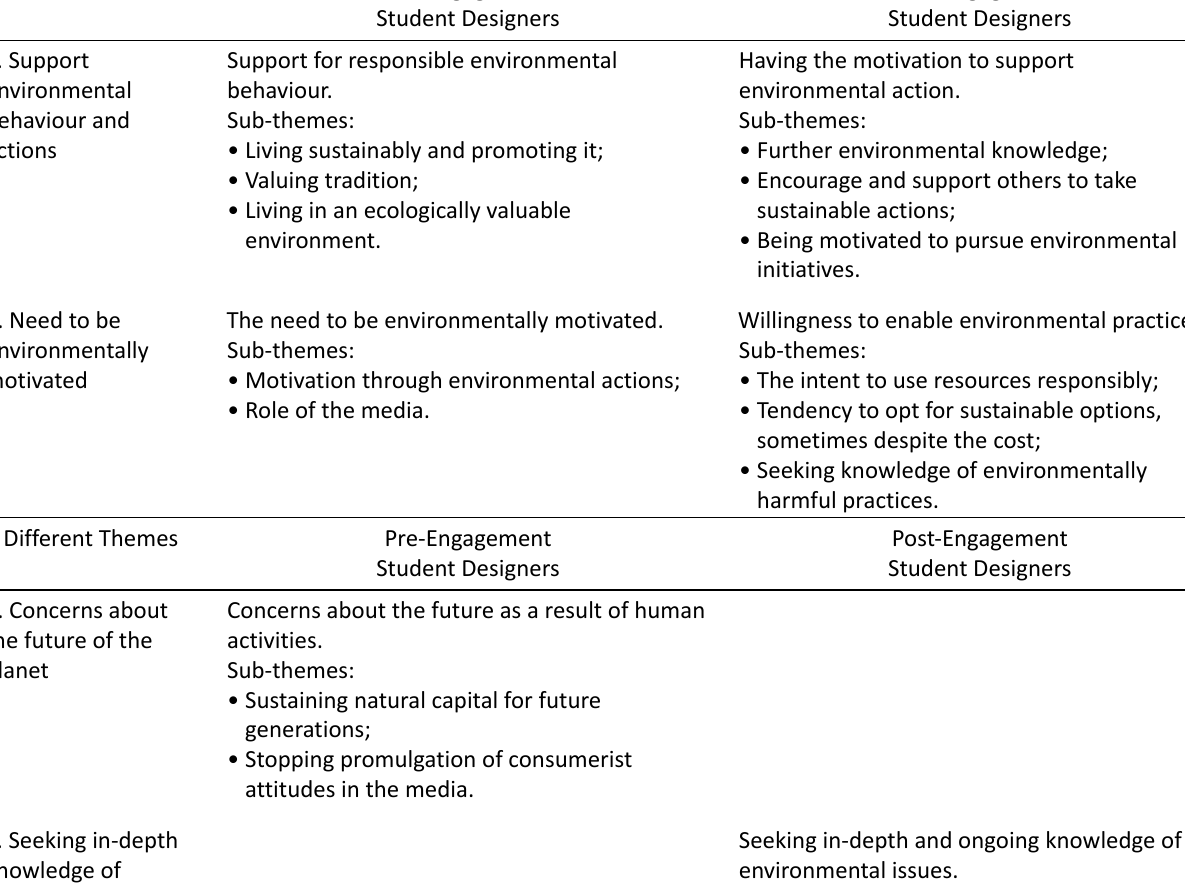
Table 1. Comparisons of themes from student designers pre‐ and post‐engagement.